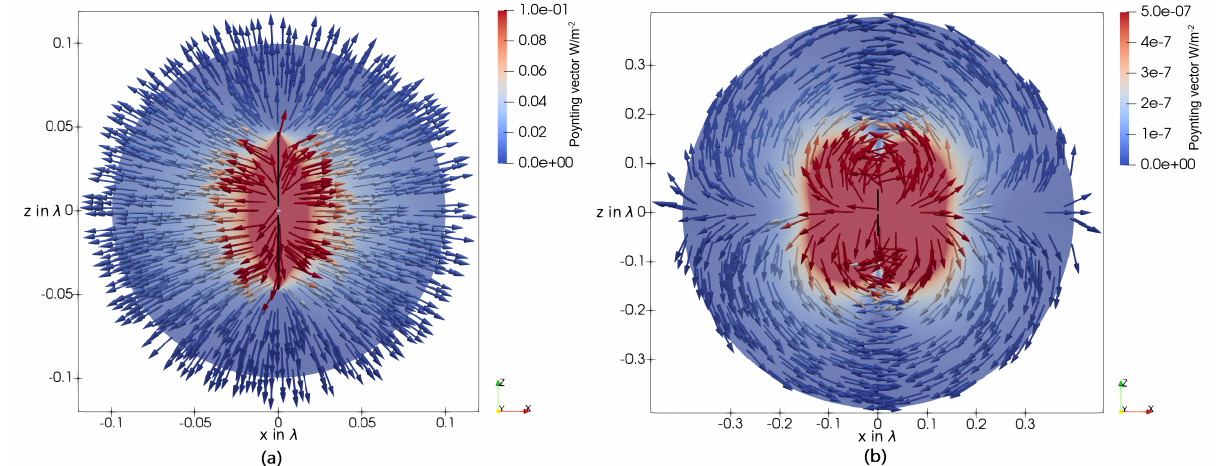
Figure 6. ( a ) The real part of the Poynting vector in the E-plane of a dipole antenna with an overall length of 0.1 λ . ( b ) The imaginary part of the Poynting vector in the E-plane of a dipole antenna with an overall length of 0.1 λ .